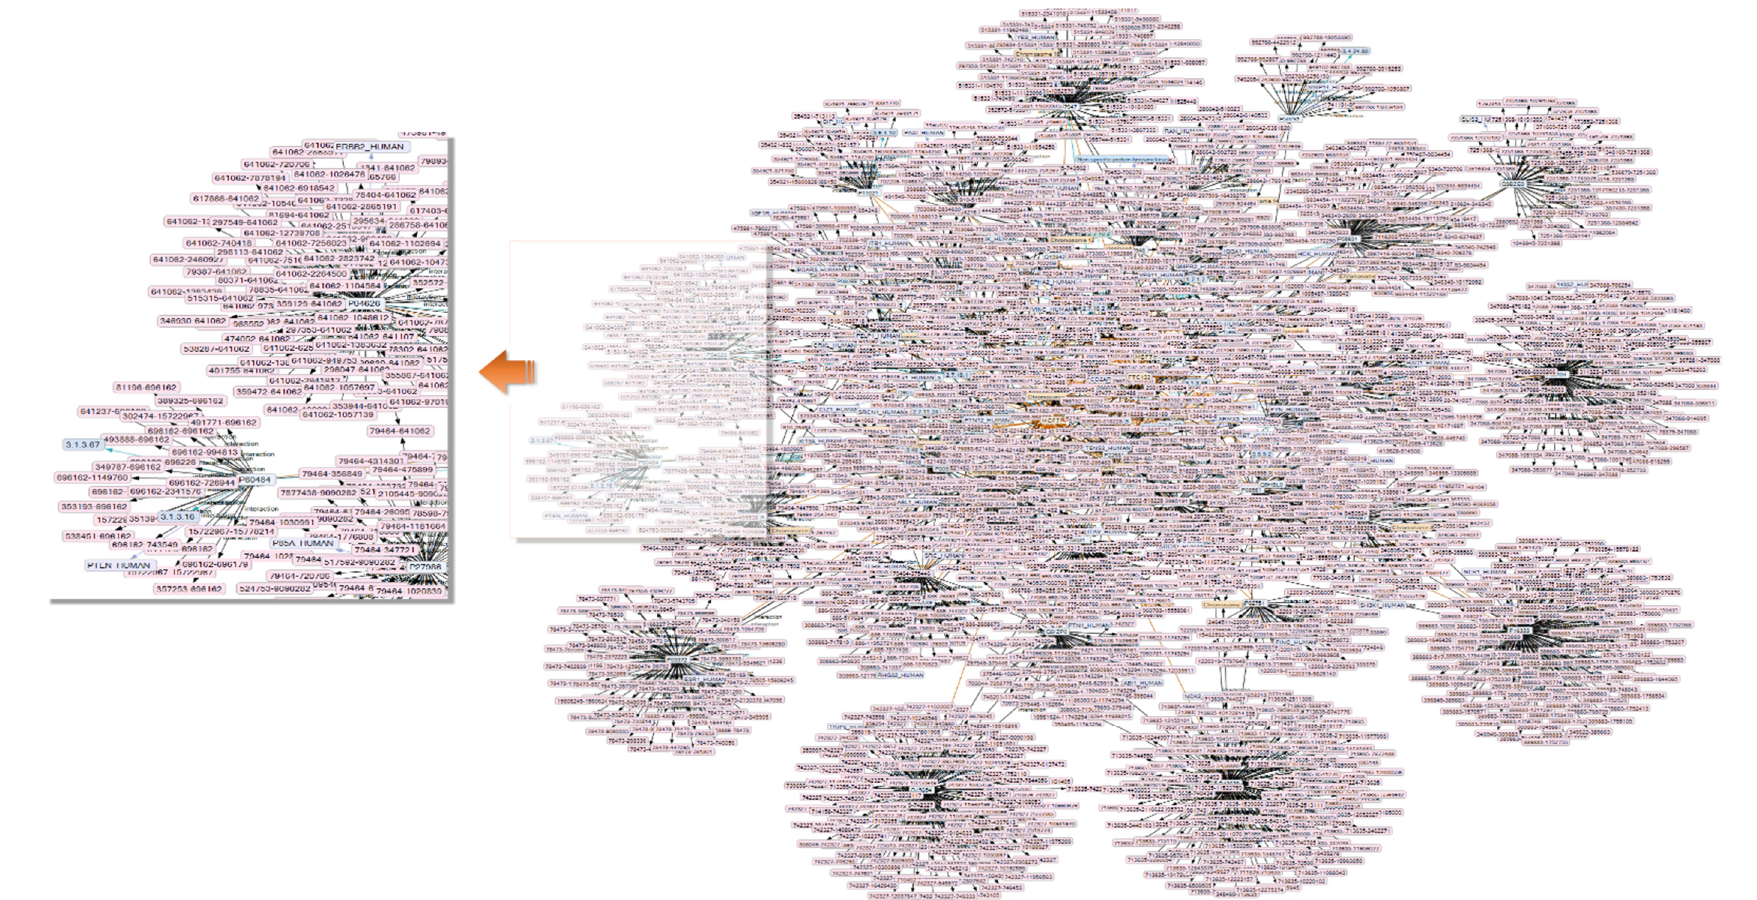
Figure 7. Two-level interactome. The first level is indicated by black nodes containing light blue rectangles with SwissProt accession numbers. Orange lines show the cell line origin of the proteins. The connection of the nodes with black lines corresponds to the networks shown in Figure 2. The second level is indicated by pink rectangles showing IntAct interaction numbers. The insert shows a magnification of the indicated part of the overview with legible numbers. The whole picture can be viewed for details at high magnification in Supplementary Figure S1. To see details here, please zoom in.